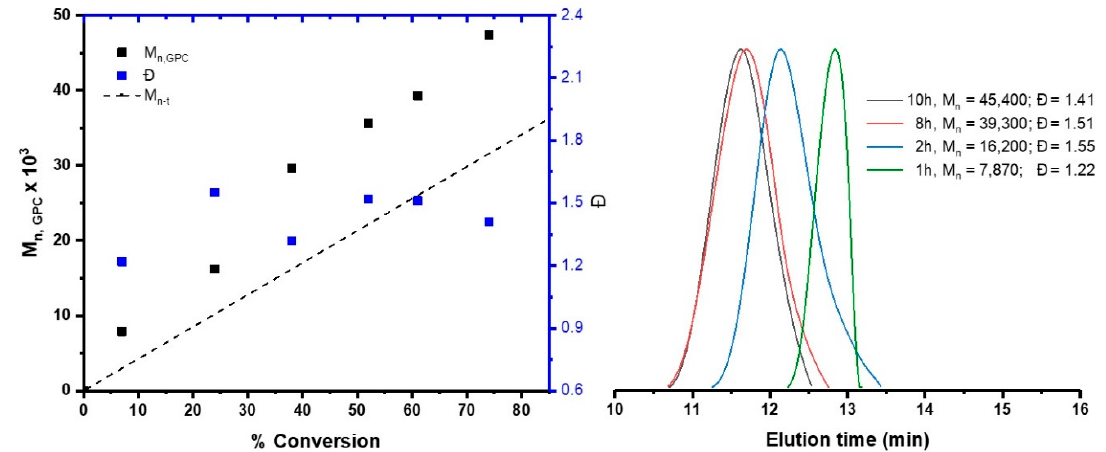
Figure 3. Evolution of the molecular weight (M n ) and dispersity (Ð) with the conversion for AMPS polymerization in DMF catalyzed by [Ru(o-C 6 H 4 -2-py)(phen)(MeCN) 2 ]PF 6 at 80 °C. [AMPS] o :[EBiB] o :[catalyst] o =